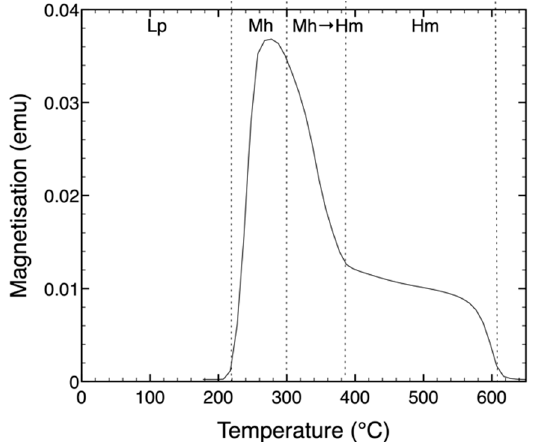
Figure 4. Magnetization of lepidocrocite (Lp) upon heating as a function of temperature. The sample was heated in air at 5 °C/min. Upon heating, Lp transforms into maghemite (Mh) at ≥ 220 °C, which subsequently transforms into hematite (Hm) upon prolonged heating at ≥ 300 °C.